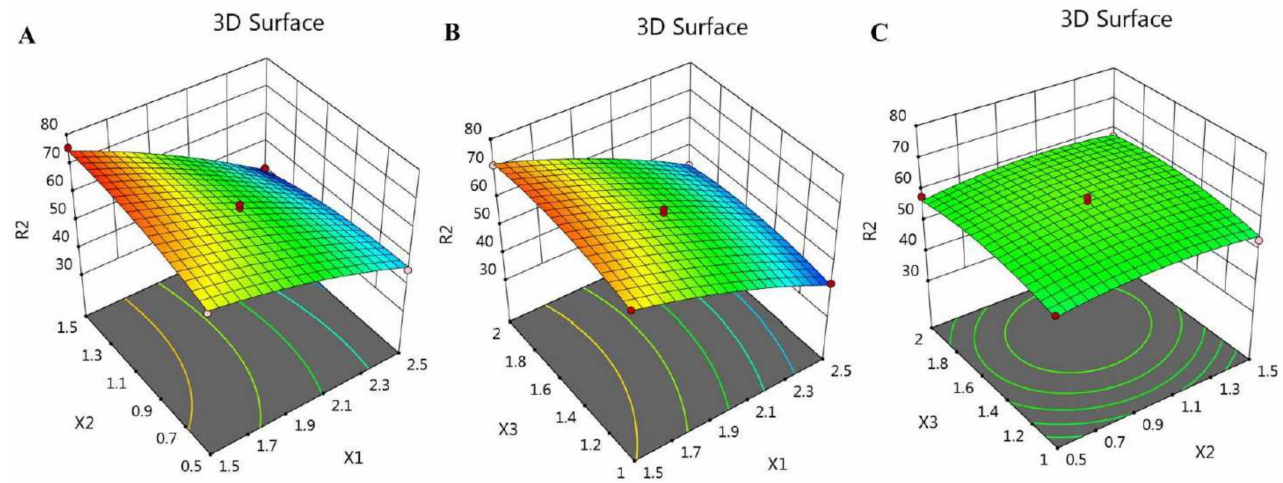
Figure 6. 3D response surface plots signifying the influence of the independent factors ( A ) X 1 and X 2 , ( B ) X 1 and X 3 , and ( C ) X 2 and X 3 on in vitro release response (R 2